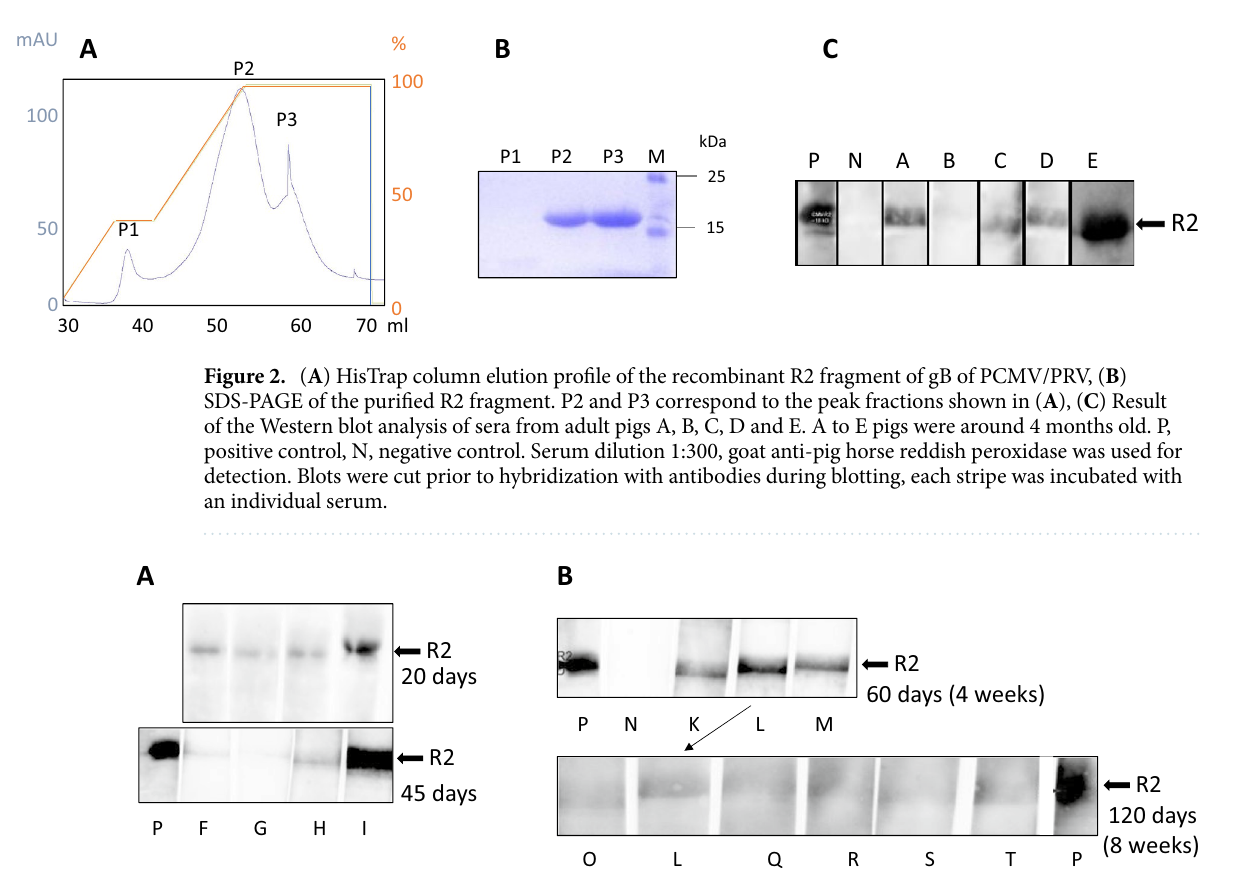
Figure 3. Detection of antibodies against the recombinant R2 fragment of the glycoprotein B in young animals. ( A ) Detection of antibodies against the R2 protein in the sera of four animals (F, G, H, I) after 20 days and after 45 days. ( B ) Detection of antibodies against the R2 fragment in the sera of eight animals (K, L, M, O, Q, R, S, T) from the same litter at day 60 and day 120. The serum from animal L was tested on both days. Animals O, L, Q, R and S, were male, T was a female. P, positive control, N, negative control. Serum dilution 1:300, goat anti-pig horse reddish peroxidase was used for detection. Blots were cut prior to hybridization with antibodies during blotting, each stripe was incubated with an individual